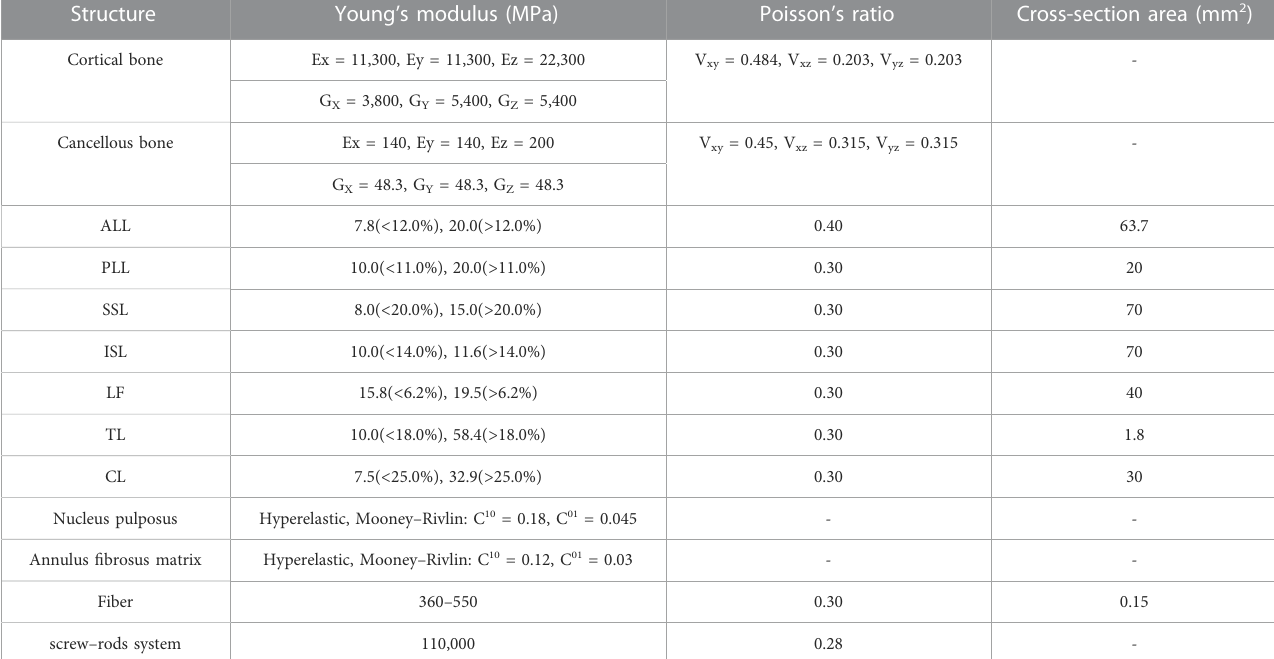
TABLE 1 Material properties of the models.